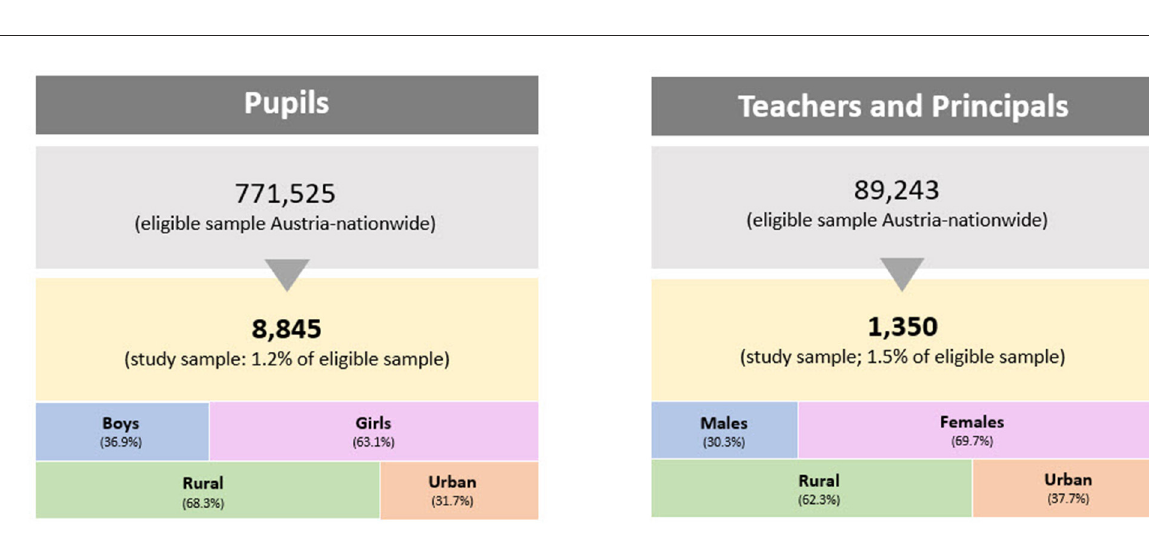
FIGURE2 Flow chart of participants’ enrollment and classifications of pupils and adults by sex and living